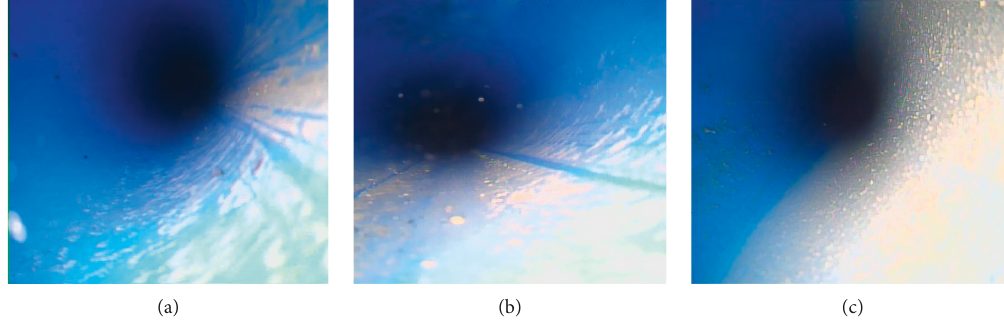
Figure 14: Polyethylene coated pipe. (a) October 28, 2016. (b) January 28, 2017. (c) April 28,